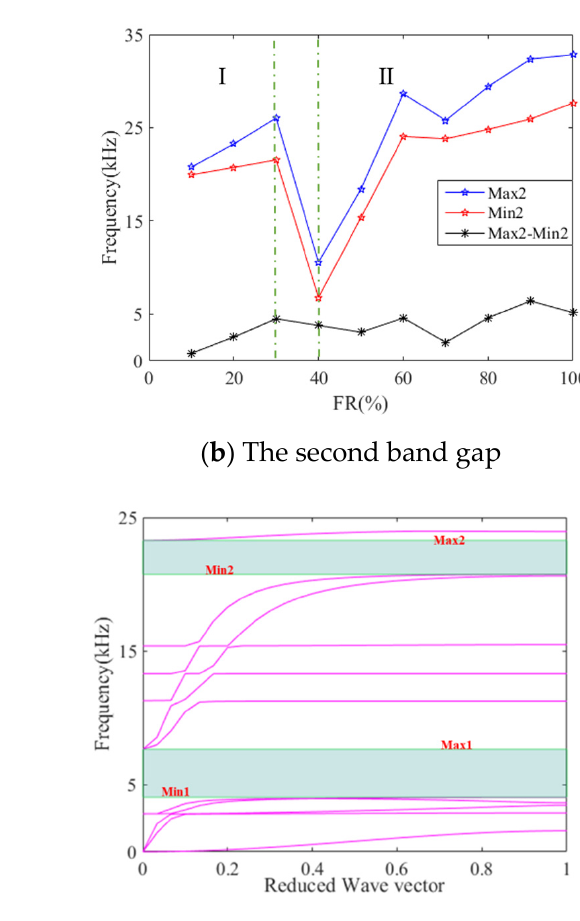
Figure 8. The influence of pillar height ratio HR on the dispersion curve of the HPFC.